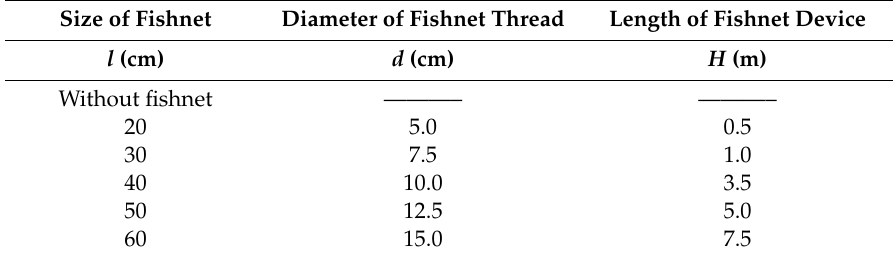
Table 2. Scenarios considered in simulation calculations.